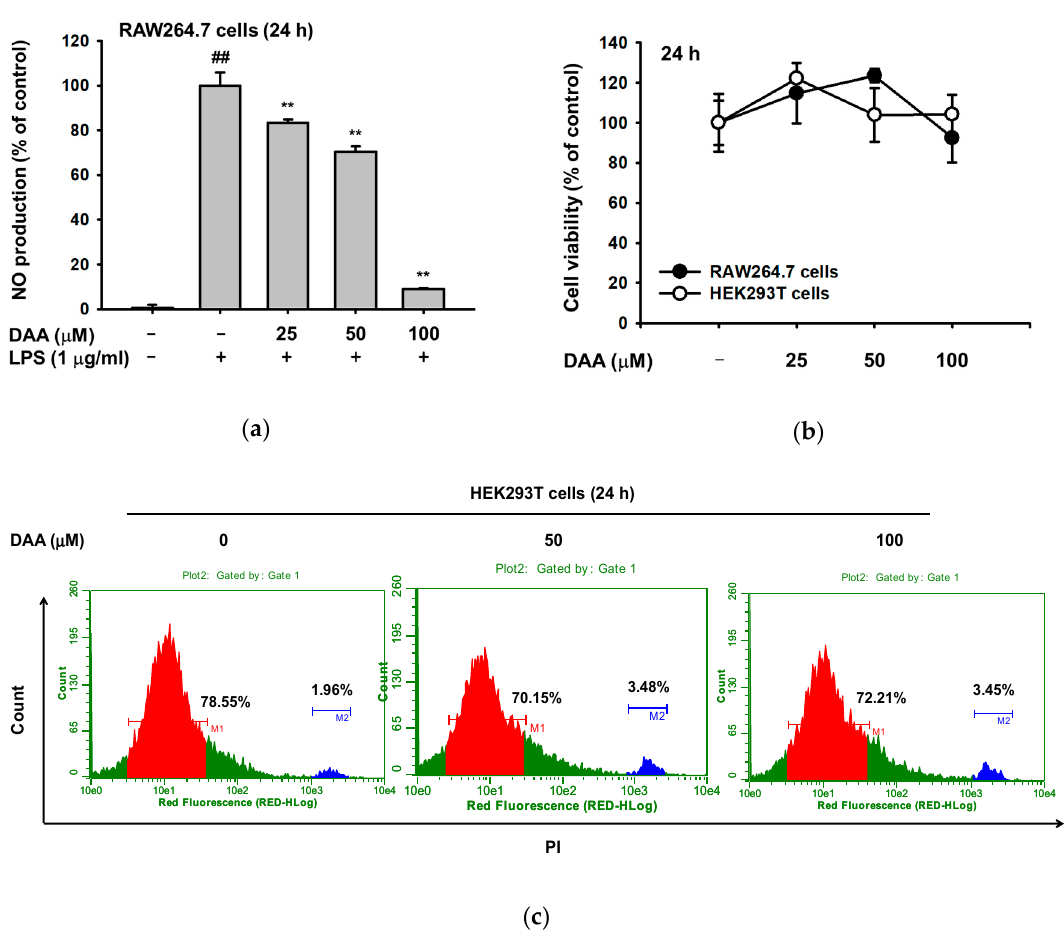
Figure 2. Effects of DAA on NO production and cytotoxicity. ( a ) DAA (0–100 µM) was pre-treated for 30 min, and LPS (1 µg/mL) was treated on RAW264.7 cells for 24 h. Cell supernatants were collected, and the production of NO was measured by Griess assay. ( b ) Cytotoxicity of DAA in RAW264.7 cells and HEK293T cells. Cells were incubated with DAA (0–100 µM) for 24 h, and then conventional MTT assay was performed. ## p < 0.01 compared to the normal group, ** p < 0.01 compared to the induced group. ( c ) Cytotoxicity of DAA in HEK293T cells was examined by PI staining analysis. The percentage of cell death was analyzed by flow cytometry.